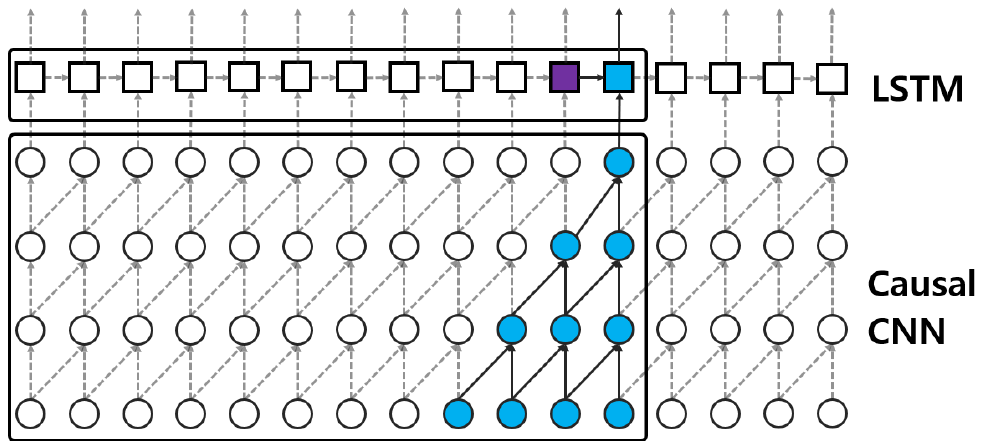
Figure 11. Learning process of SCLRCN (Note: Purple denotes data in the past and currently needed, Blue denotes the number of nodes needed in current operation).